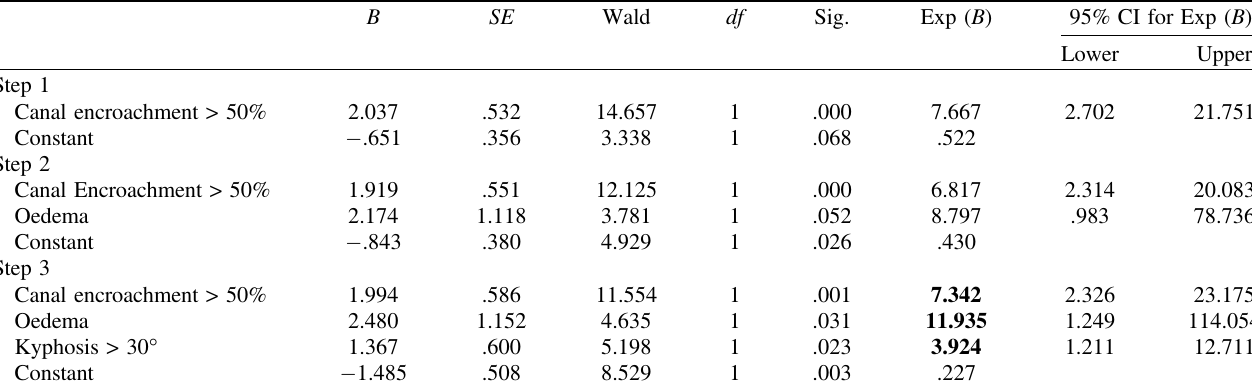
Table 3. Multivariate analysis including showing Kyphosis > 30 (cid:1) , canal encroachment (>50%) and Cord oedema as independent risk factors associated with neurological de fi cit B – unstandardized beta, SE – standard error of regression, Wald- type of statistic used in logistic regression analysis, df – degrees of freedom, Sig. – signi fi cance value, Exp( B ) – odds ratio, CI – con fi dence interval.